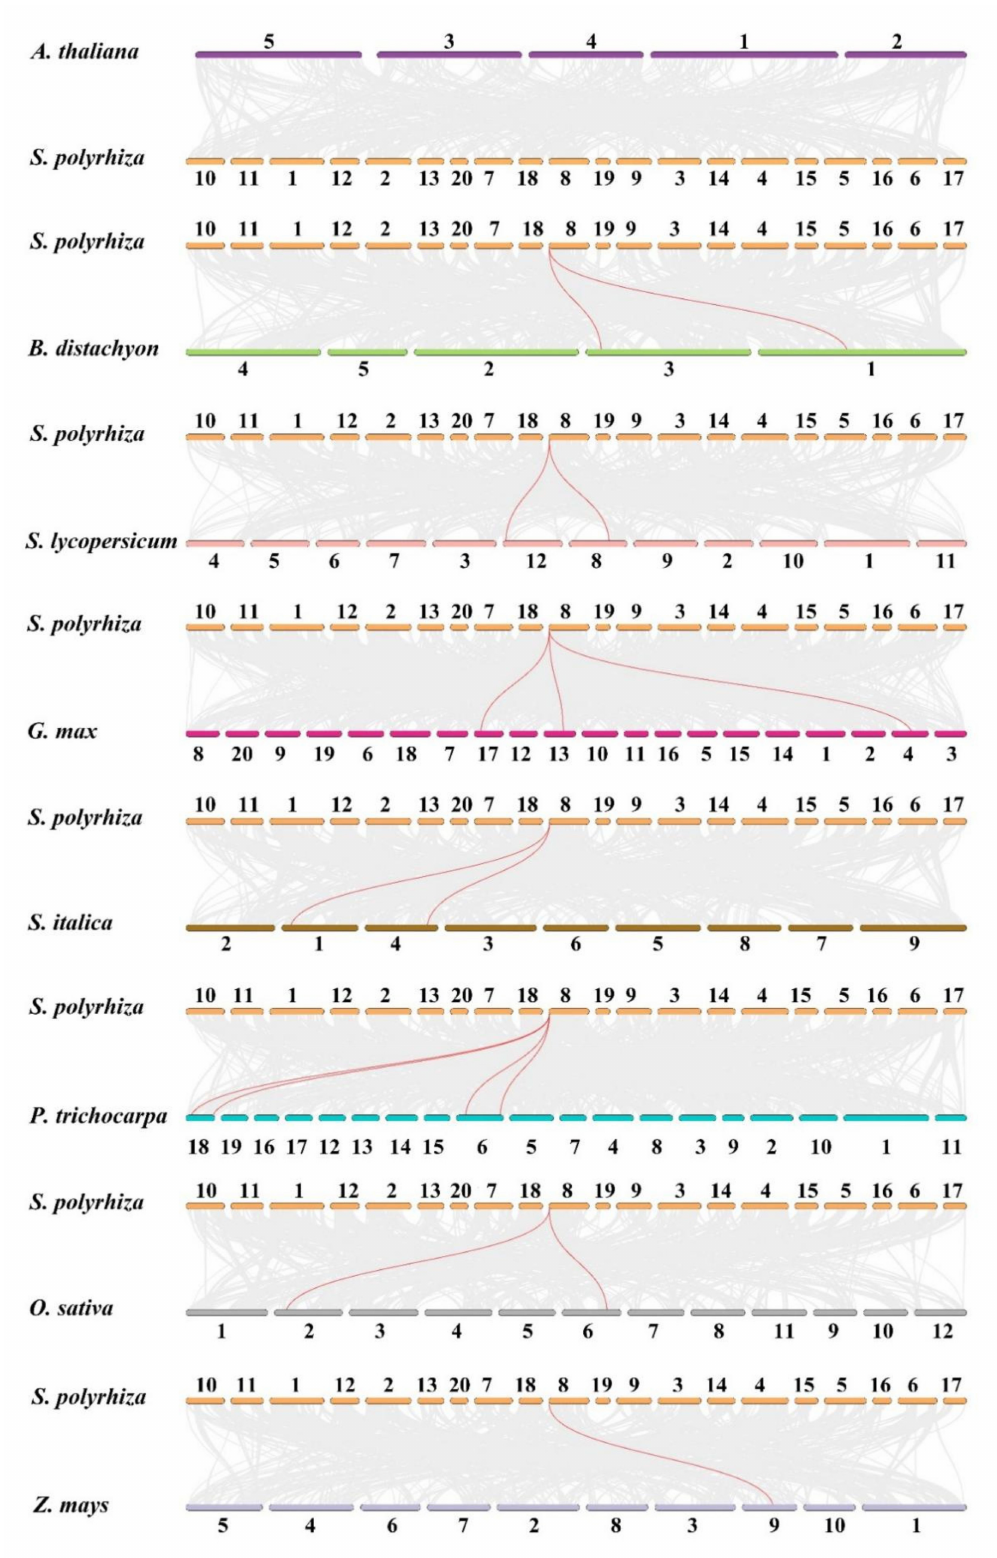
Figure 5. Synteny relationship of SPX genes pairs between S. polyrhiza and other seven plant species. Red represents syntenic SPX genes, and gray lines show the collinear blocks of the plant genome. The chromosome number was labeled at the top of each